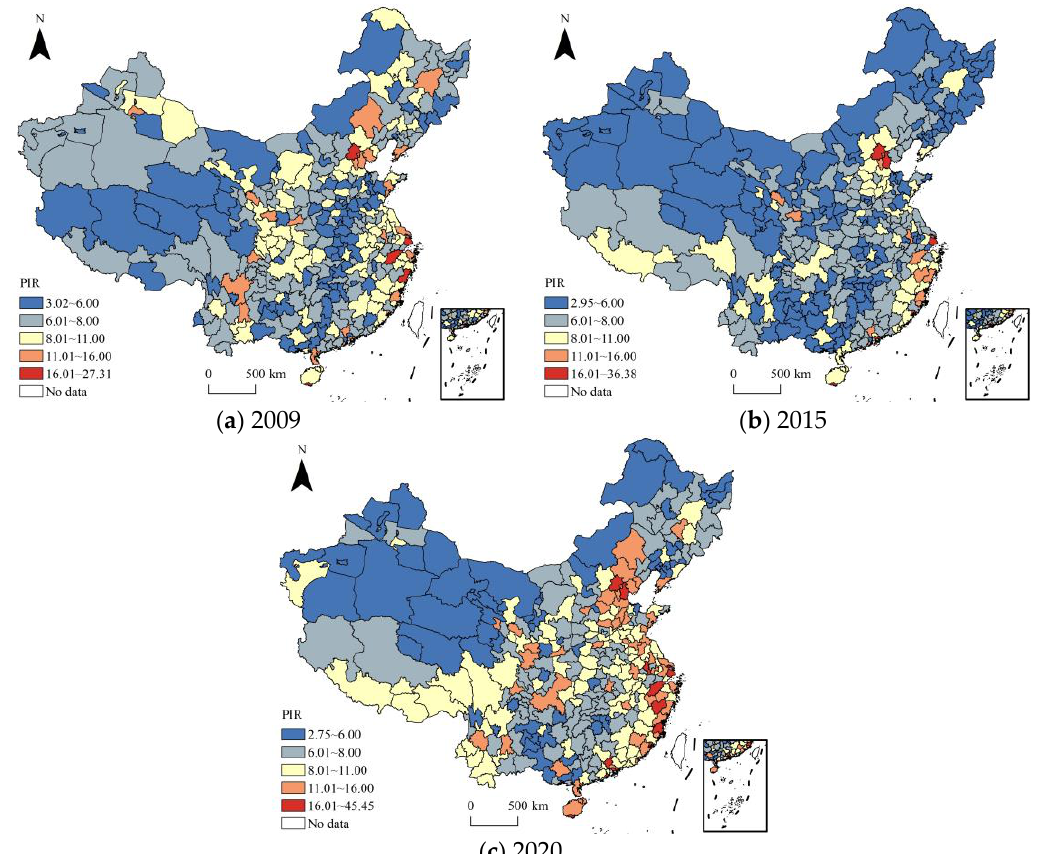
Figure 1. Spatial differentiation pattern of PIR in China during 2009 – 2020.